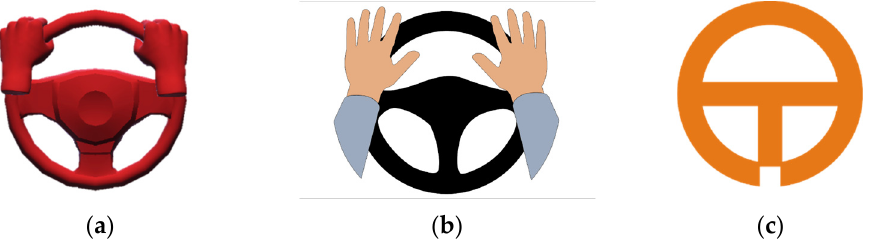
Figure 1. RtI icons tested in the ITS laboratory: ( a ) “red hands on steering wheel” icon, ( b ) “natural hands on steering wheel” icon, ( c ) orange wheel icon.